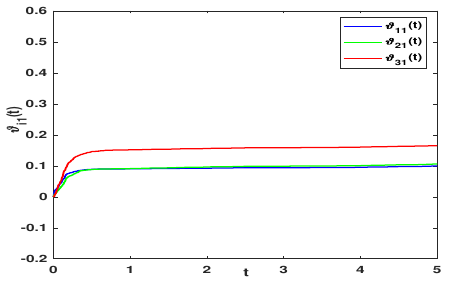
Figure 7. The adaptive laws ϑ i 1 ( t ) .